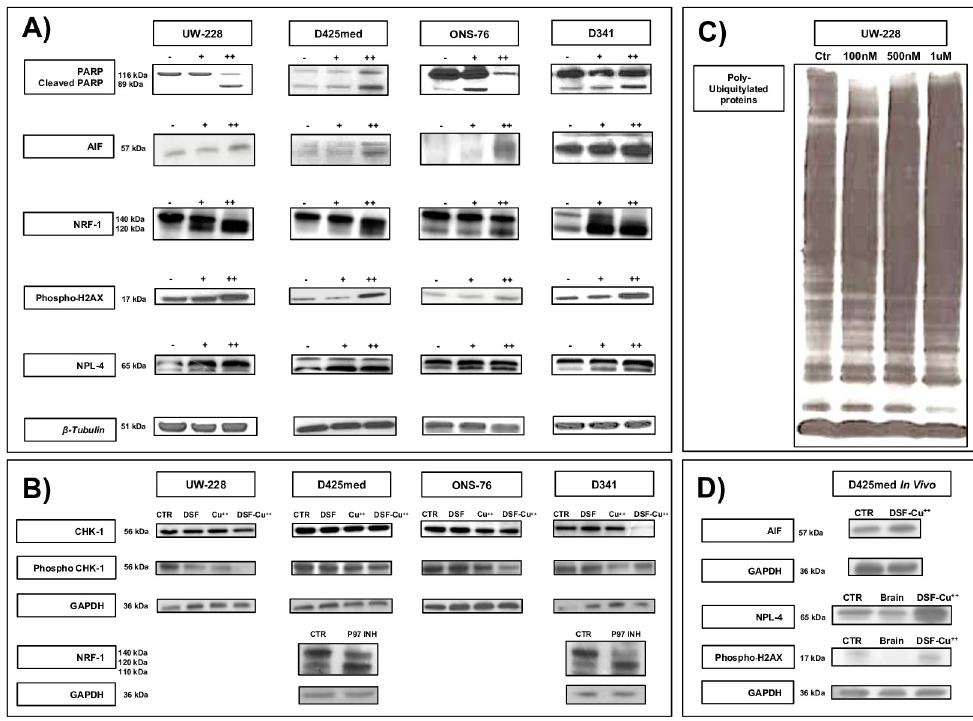
Fig 3. Western blot of MB lines treated with DSF/Cu ++ . (Panel A) Cleaved-PARP fraction and AIF increased after DSF-Cu ++ treatment, as well as NPL4 and Phospho-H2AX. Multiple fractions of NRF1 confirmed the inhibition of this transcription factor, and a similar cleavage profile was found after treatment of D425-D341 cells with a p97-inhibitor, suggesting the involvement of this intracellular pathway (Panel B) . Changes in Chk-1 and Phospho-Chk-1 suggest an effect of DSF-Cu ++ on the DNA repair mechanisms, and a reduction in these markers is triggered only by the use of combination DSF-Cu ++ (Panel B) . Furthermore, DSF-Cu ++ and CUET consistently determine an intracytoplasmic accumulation poly- ubiquitylated proteins in UW228 cells (Panel C) . In vivo western blotting of control and DSF-Cu ++ -treated tumor tissue, as well as of normal brain, showed an increase in AIF, NPL4 and H2AX after treatment, consistently with in vitro findings (Panel D) . Legend;—control, + 0.5 μ M for 24h, ++ 1 μ M for 24h; DSF 150nM 24h, Cu ++ 150nM 24h, DSF-Cu ++ 150nM 24h. In vivo DSF-Cu ++ -treated brains were obtained from D425med tumors treated with oral DSF (150mg/kg daily) and Cu ++ (2mg/kg daily).